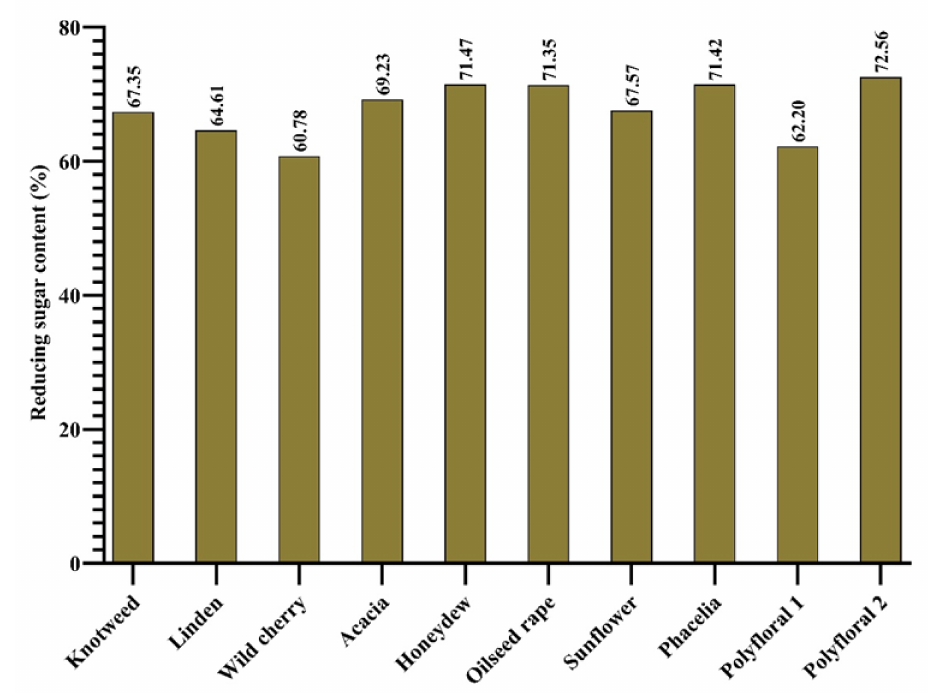
Figure 4. Reducing sugar content